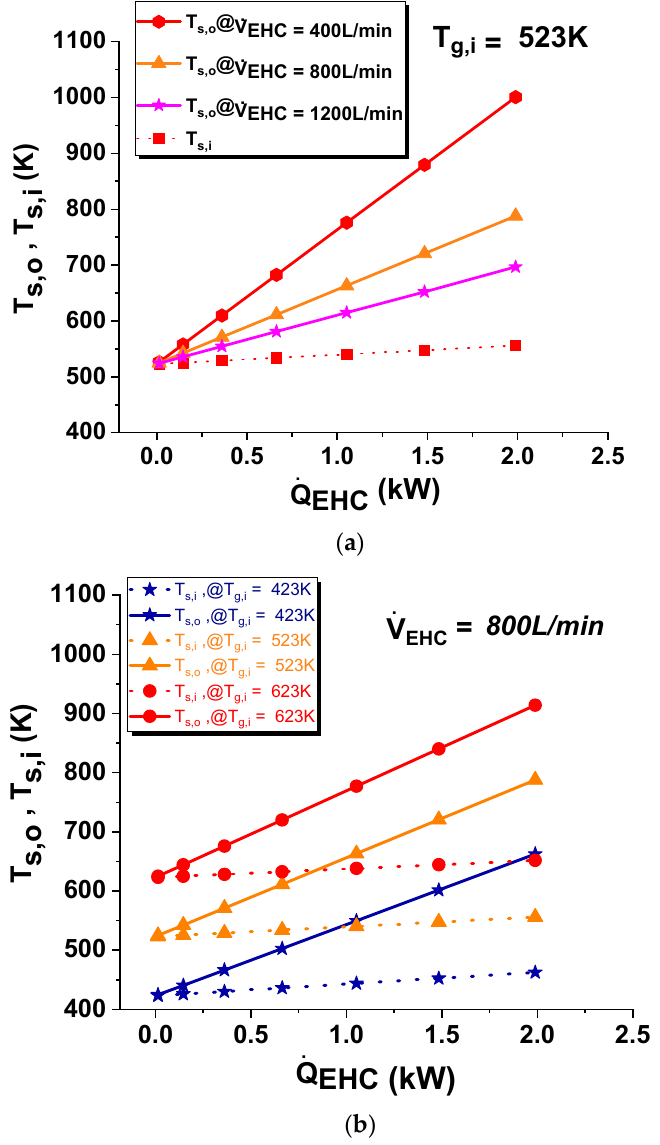
. . T V  Q  V EHC ) and temperature ( T g , i ) of exhaust gas and heater power ( Q EHC ) Figure 9. Effect of flow rate ( Figure 9. Effect of flow rate ( EHC ) and temperature ( , g i ) of exhaust gas and heater power ( EHC . . V EHC and Q EHC , ( b ) effect of on the heater surface temperature distribution in the EHC: ( a ) effect of . T g , i and Q EHC ( D cell = 2.7 mm, L cell = 20 ) on the heater surface temperature distribution in the EHC: ( a ) effect of